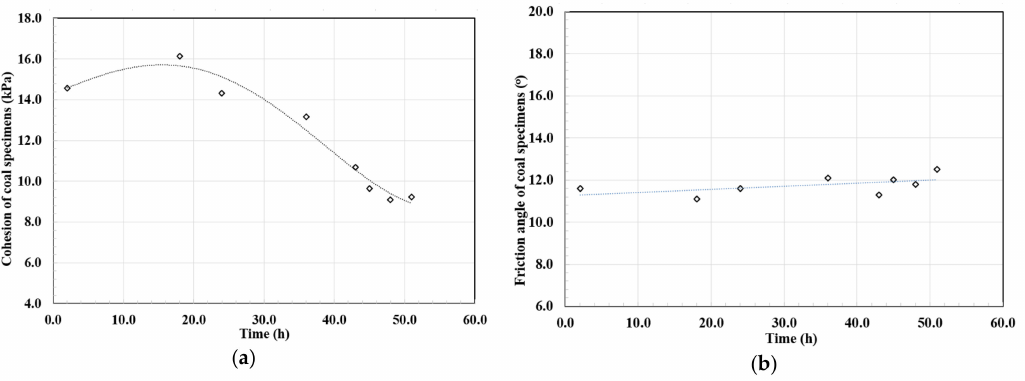
Figure 8. E ff ect of the water injection time on the strength properties of coal samples: ( a ) E ff ect on cohesion; ( b ) e ff ect on the friction